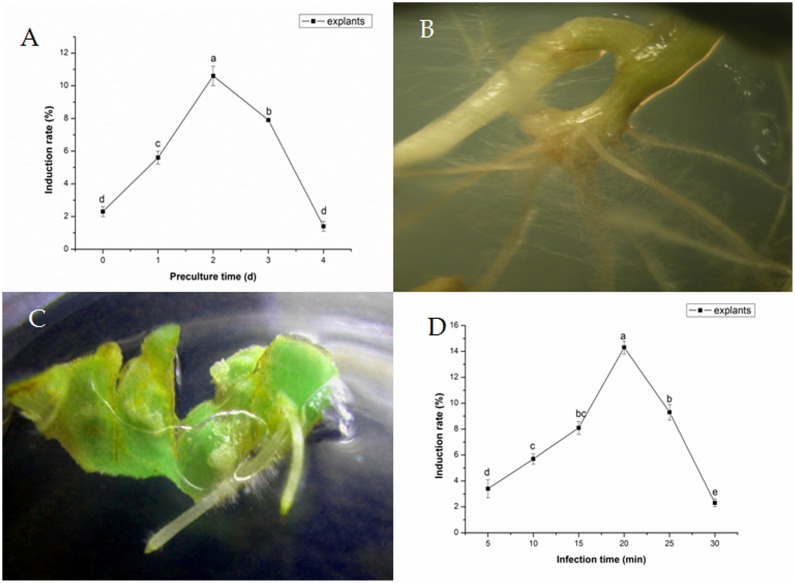
Effects of preculture time (A) and Agrobacterium rhizogenes infection time.
(B) Development of hairy roots from a petiole segment within 10 days. (C) Development of hairy roots from cotyledon within 5–7 days. (D) On transformation frequency of Fagopyrum tataricum.